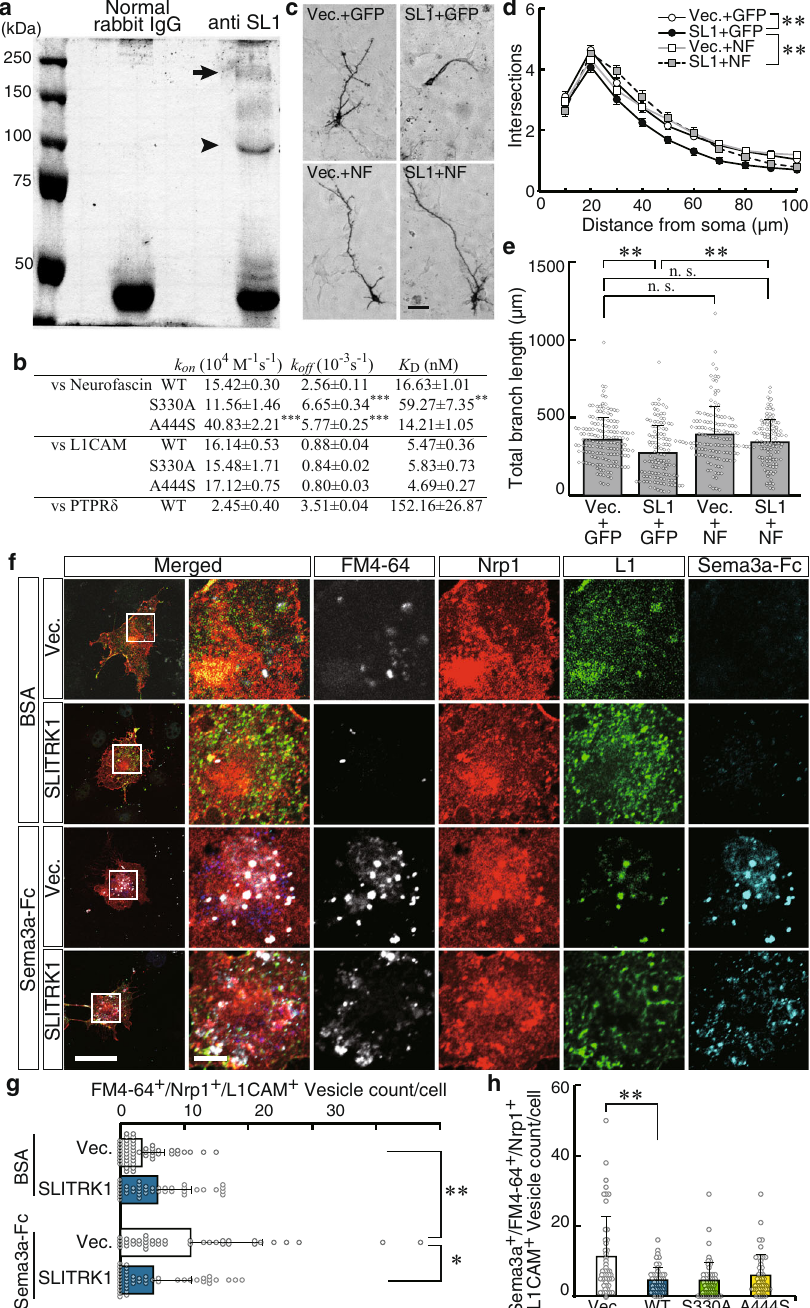
Fig. 9 SLITRK1 physically interacts with L1CAM family proteins. a Coomassie brilliant blue-stained sodium dodecyl-sulfate polyacrylamide gel electrophoresis after immunoprecipitation using anti SLITRK1 or normal rabbit IgG. 200 kDa band ( arrow ) and 100 kDa band ( arrowhead ) were excised and subjected for mass-spectrometry analysis (Supplementary Table 3). The blot image was uncropped. b K D , k on , and k off values of SLITRK1 or its variants- binding to Neurofascin, L1CAM, and PTPR δ are presented as mean ± SD (Neurofascin and PTPR δ , n = 3; L1CAM, n = 6 experiments). c Representative images of cultured cortical neurons overexpressing SLITRK1 and Neurofascin ( SL1 + NF ). Vec., empty vector (negative control for SLITRK1-expressing plasmid); GFP (control for Neurofascin). d Sholl analysis. Open circle , empty vector + GFP ( n = 151 cells); fi lled circle , SLITRK1 + GFP ( n = 117 cells); gray rectangle , SLITRK1 + Neurofascin ( n = 103 cells); open rectangle , empty vector + Neurofascin ( n = 132 cells). Values are presented as mean ± SEM. e Total branch length. f – h Effects of SLITRK1 on L1CAM-mediated endocytosis of the Sema3a receptor Nrp1. Nrp1/L1CAM-expressing or Nrp1/L1CAM/SLITRK1- expressing COS7 cells were incubated in a medium containing FM4-64 (a fl uorescein probe for plasma membrane) with Sema3a or BSA. FM4-64 + / Nrp1 + /L1CAM + particles ( g ) or FM4-64 + /Nrp1 + /L1CAM + /Sema3a + particles ( h ) were counted in each cell. g Vec. (BSA), n = 51; SLITRK1 (BSA), n = 40; Vec. (Sema3a), n = 39; SLITRK1. (Sema3a), n = 45 cells. h Vec., n = 48; WT, n = 48; S330A, n = 51; A444S, n = 48 cells. Values are presented as mean ± SD ( e , g , h ). * P < 0.05; ** P < 0.01; *** P < 0.001 in the Dunnett ’ s test ( b ), Steel ’ s test ( e , g , h ), or Tukey ’ s test ( d ). Scale bar , 50 µ m ( c , f , low magni fi cation), 10 µ m ( f , high magni fi